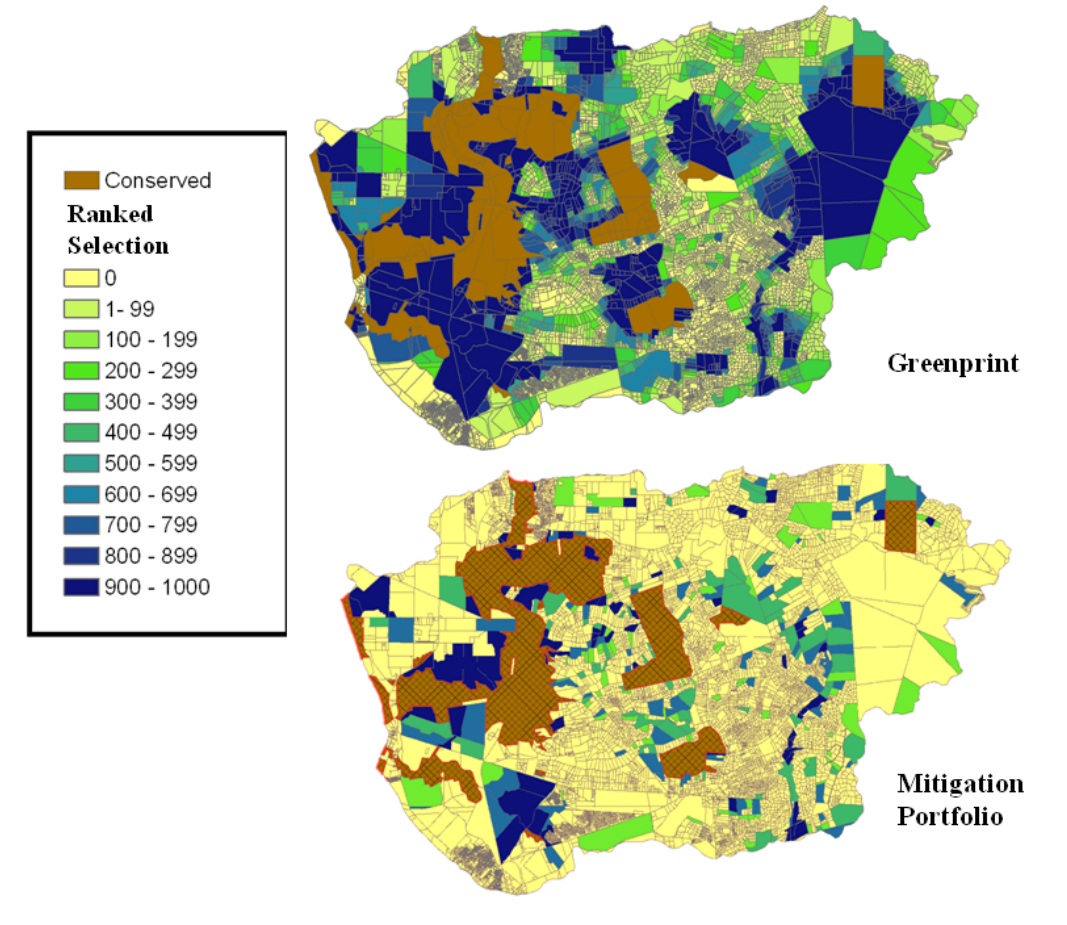
Fig. 4. The Elkhorn Slough regional greenprint and mitigation portfolios, as identified through the MARXAN runs. The upper image is the regional conservation potfolio using representation targets set by the local environmental group, the Elkhorn Slough Foundation. The lower image is a portfolio of sites that could meet the mitigation needs for four Caltrans projects planned in the watershed. The darkest-blue parcels contain biological resources that are limited, and thus, are more difficult to substitute for other parcels. The lighter parcels may be just as highly suitable, but the resources they contain could be found on other parcels. In the lower map, any parcel with a color other than tan, can be thought of as a candidate for fulfilling mitigation